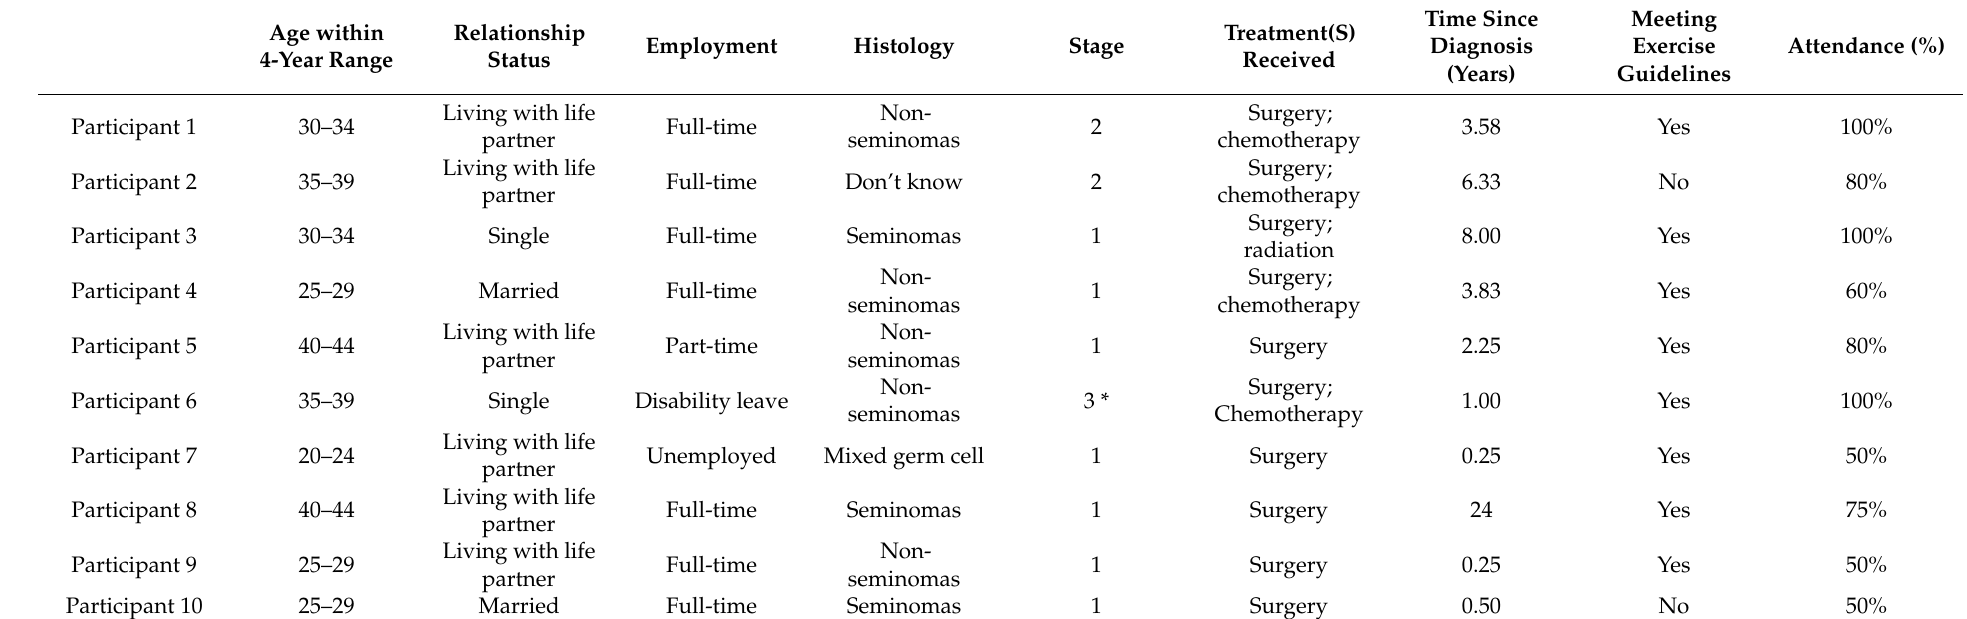
Table 2. Demographics and baseline characteristics of participants (N =